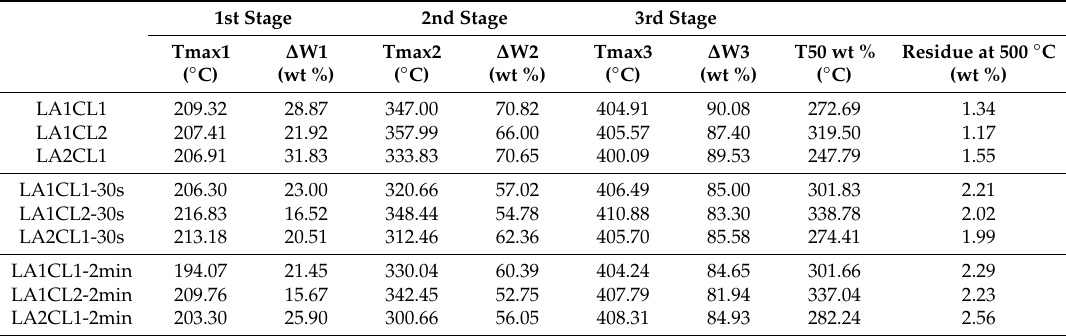
Figure 6. Thermograms registered for the blended macromers ( A ) and their crosslinking products obtained with 30 s ( B ) and 2 min ( C ) of UV irradiation. Figures A’ , B’ and C’ show the correspondent derivative thermogravimetry (DTG) thermograms. Table 2. Summary of the main registered thermal events in thermo gravimetric analysis (TGA). Tmax represents the temperature value corresponding to the highest degradation rate at each degradation stage and ∆ W represents the correspondent weight loss (%). T50 represents the temperature at which samples’ weight decreased to 50% of the initial one.